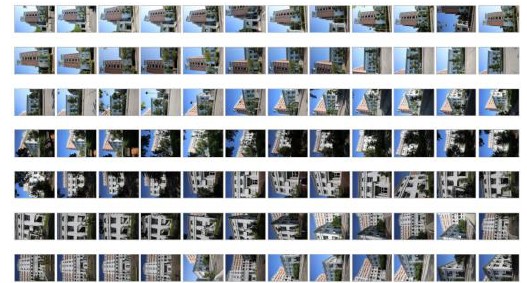
Figure 6. Part of multiview images taken from the ground of the area surrounding the